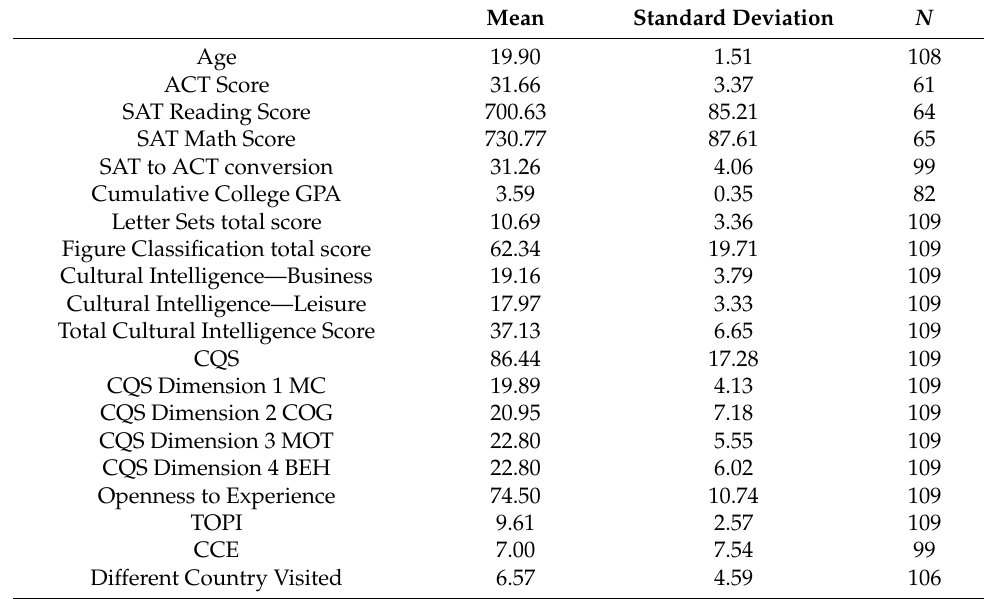
Table 1. Mean scores and standard deviations.